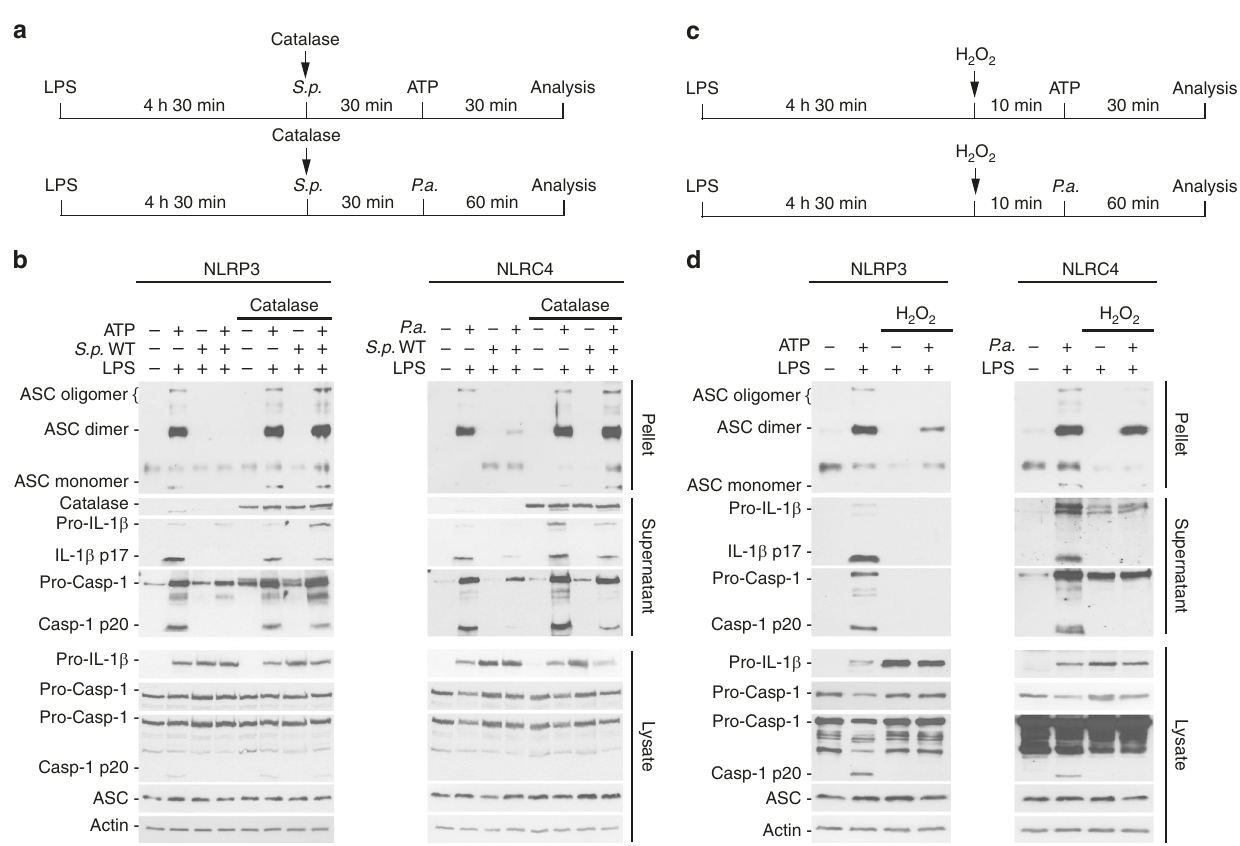
Fig. 6 S. pneumoniae impairs in fl ammasome activation via SpxB-mediated H 2 O 2 release. a Schematic diagrams of the experimental setups used in ( b ). b ASC oligomers, Caspase-1 and IL-1 β processing in LPS-primed BMDMs pre-treated with S.p . WT (D39, MOI 100) in the presence of catalase (100 U mL − 1 ) for 30 min before ATP stimulation (5 mM, 30 min) or P.a . infection (MOI 20, 60 min). c Schematic diagrams of the experimental setups used in d . d ASC oligomers, Caspase-1 and IL-1 β processing in BMDMs pre-treated with 50 µ M H 2 O 2 for 10 min prior to stimulation with ATP (5 mM, 30 min) or infection with P.a . (60 min, MOI 20). The data in b and d are representative of three independent experiments. Source data are provided as a